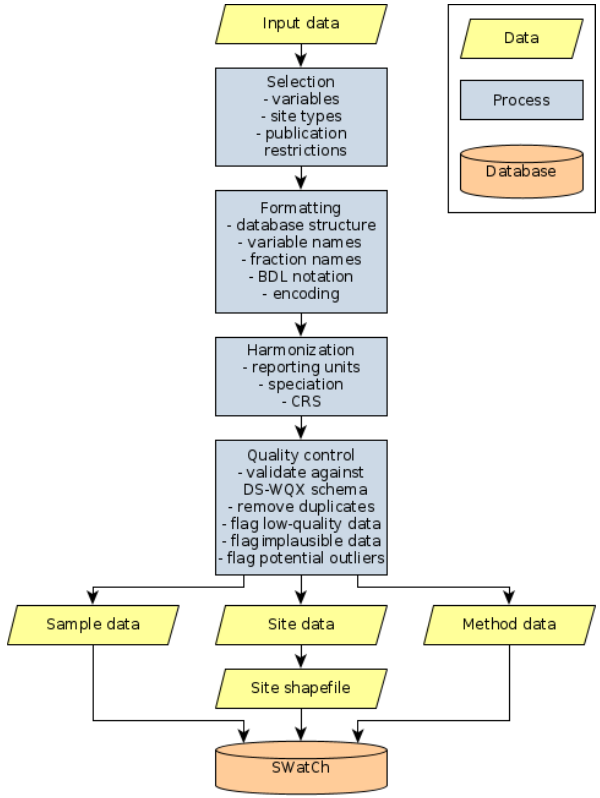
Figure 1. Workflow for creating SWatCh. Below detection limit is abbreviated as BDL, and coordinate reference system is abbreviated as